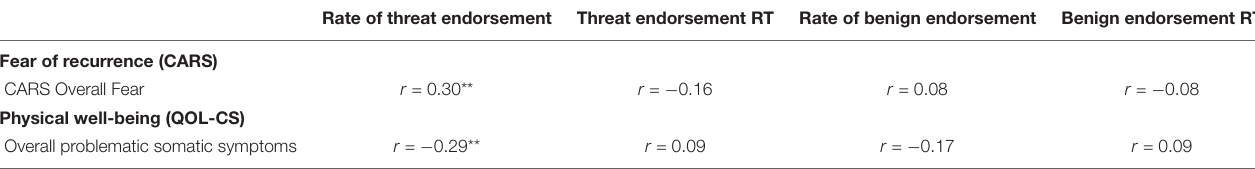
TABLE 1 | Baseline correlations between cancer-related interpretation bias and psychological and somatic